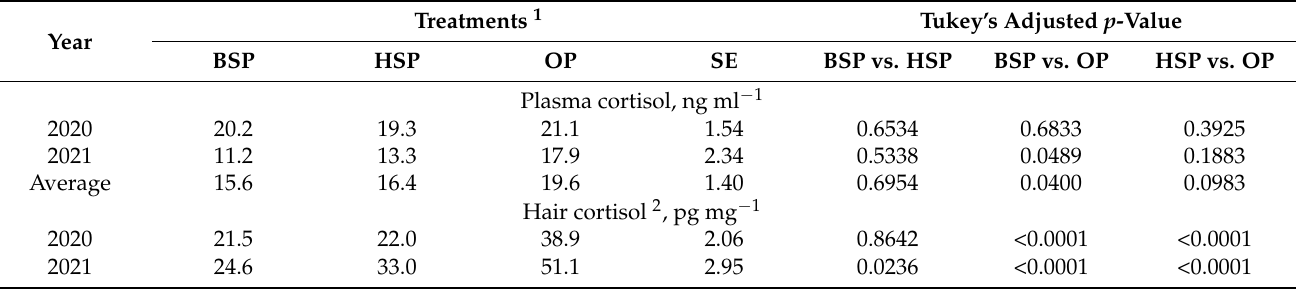
Table 6. Plasma cortisol level (ng ml − 1 ) and hair cortisol level (pg mg − 1 ) of Katahdin ewes that grazed either open pasture (OP), black walnut silvopasture (BSP), or honeylocust silvopasture (HSP) treatments during the summers of 2020 and 2021.